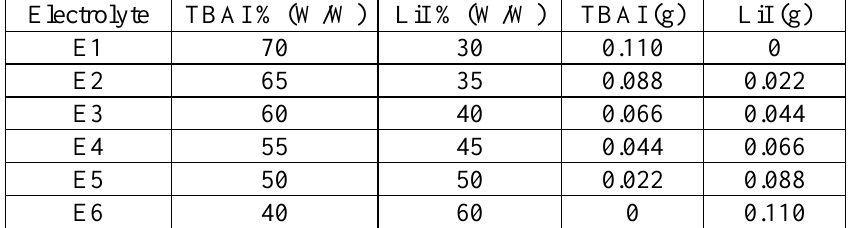
Table 1: Weight ratio of TBAI and LiI used to prepare polymer electrolytes.